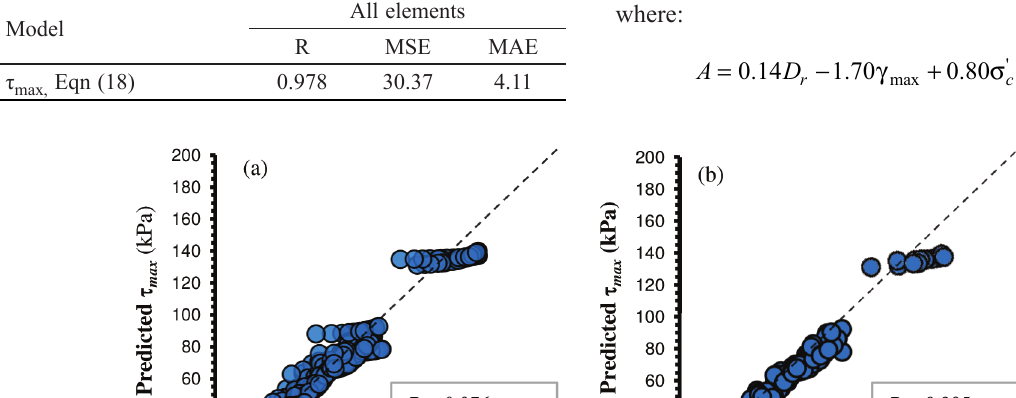
Table 6. Overall performance of the proposed LGP model Model